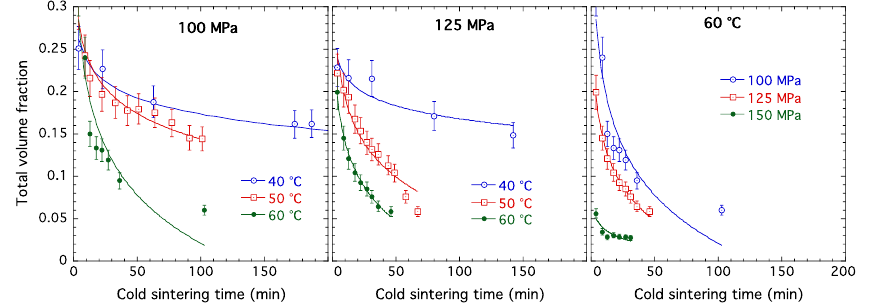
Figure 4. Total pore volume fraction versus cold sintering time for 40 °C, 50 °C, 60 °C with p = 100 MPa and 125 MPa, and for p = 100 MPa, 125 MPa, 150 MPa at 60 °C. Logarithmic line fits are guides to the eye. Vertical bars in this and subsequent figures (unless stated) are estimated standard uncer- tainties based on USAXS intensity calibration and residual stochastics in CSP densification still pre- sent using the custom-built CSP stage.